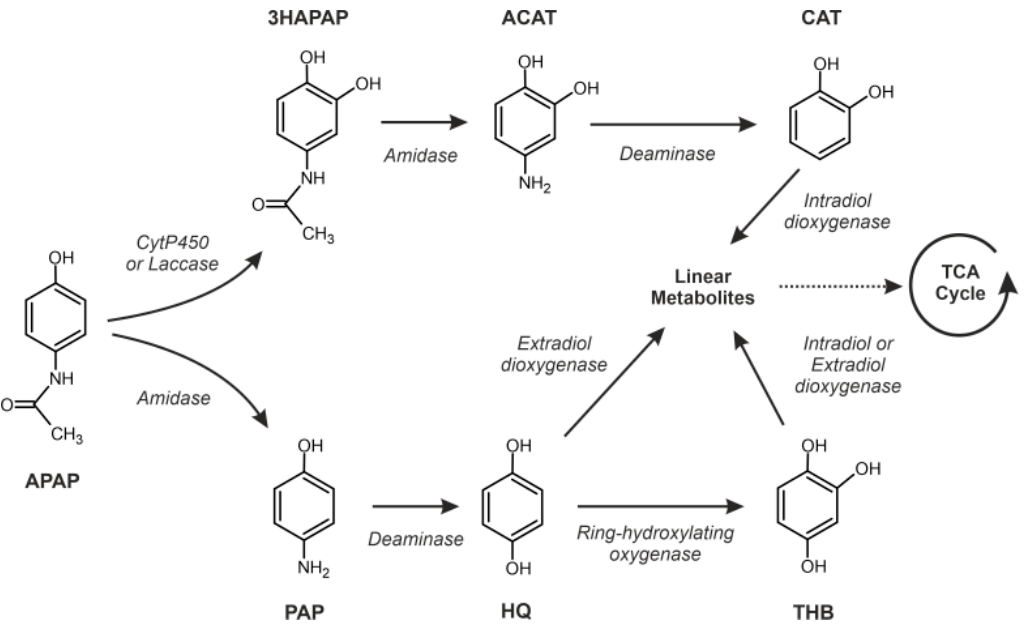
Figure 8. Proposed metabolic pathways for the degradation of APAP by P. chrysogenum var halophenolicum indicating the involved enzymes. APAP, acetaminophen; 3HAPAP, 3-hydroxyacetaminophen; ACAT, 4-aminocatechol; CAT, catechol; PAP, 4-aminophenol; HQ, hydroquinone; and THB, 1,3,4-trihydroxybenzene.